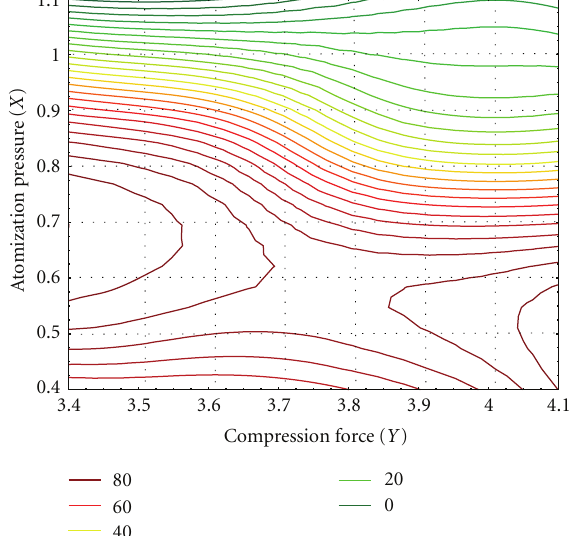
Figure 5: Contour plot which describes the influence of atom- ization pressure and compression force on the percent of released paracetamol after 30min.